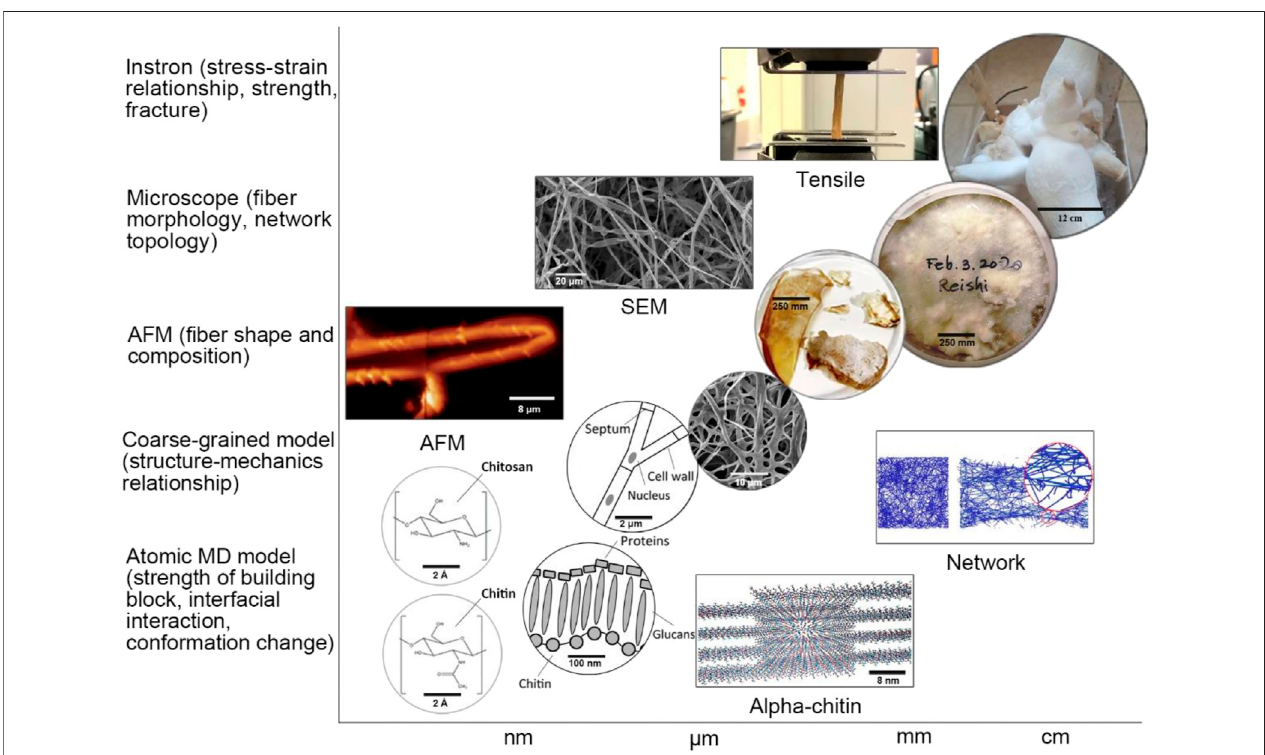
FIGURE 5 | Multiscale structure of the mycelium. From the bottom left, the fi gure shows the molecular formula of chitin and chitosan, followed by two fi gures showing the structure of the single mycelium and mycelium cell wall and the SEM image of the mycelium network, as well as two fi gures showing the wet and dry mycelium samples inthe culturing disk.The last fi gure at the right-up corner shows thecultured king oyster mushroom. We can usedifferentresearch methods to study the structure-function relationship of the mycelium network at different scale levels, as noted at the axis of the plot (The AFM fi gure is reproduced under a creative commons attribution license) (Haneef et al.,